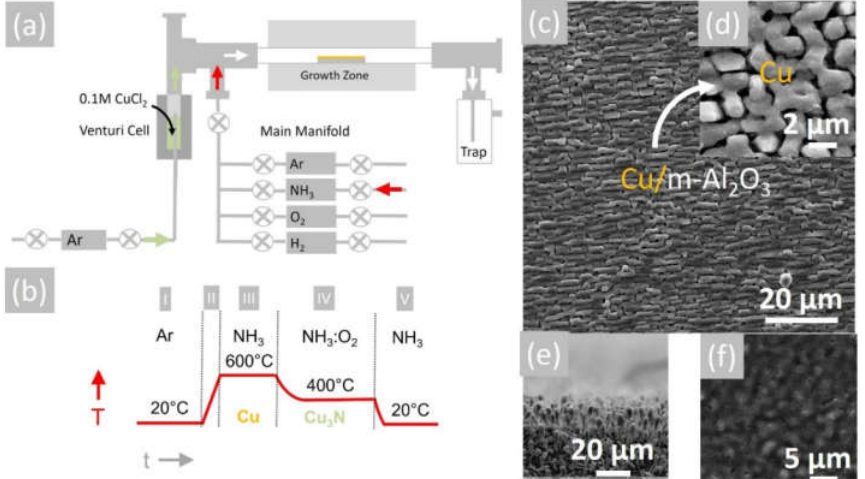
Figure 1. ( a ) Schematic of 1” AACVD hot wall-reactor; ( b ) temperature–time profile for the deposition of Cu and conversion to Cu 3 N ( c ); ( d ) SEM image of Cu on m-Al 2 O 3 obtained at 600 °C showing ordering of the grains; ( e ) side view of SEM image of Cu on m-Al 2 O 3 obtained at 600 °C showing columnar growth; ( f ) SEM image of Cu 3 N obtained from Cu under NH 3 : O 2 at 400 °C.